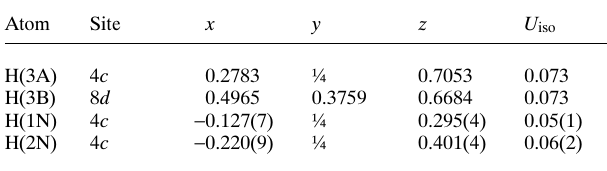
Table 2. Atomic coordinates and displacement parameters (in Å 2 )